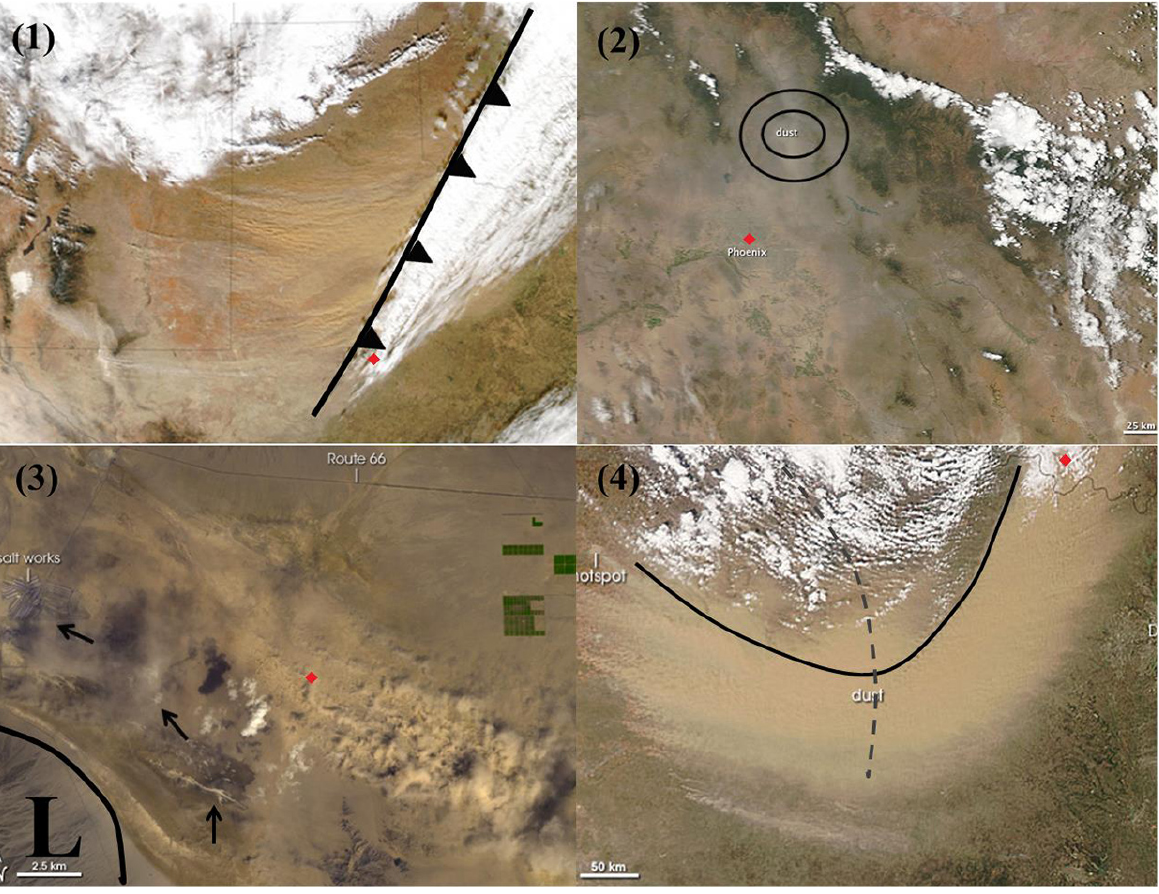
Figure 1. Four typical dust storms over the western United States: visible satellite images and corresponding weather systems for the storms. (1) Dust storm caused by cold front (D1), 15 December 2003, at Texas and Oklahoma border. (2) Dust storm caused by meso- or small- scale system (D2), 5 July 2011, near Phoenix, Arizona. (3) Dust storms caused by disturbances (D3), 12 April 2007, near Amboy, southern California. (4) Dust storm caused by cyclogenesis and associated trough cutoff (D4), 24 February 2007, west of Dallas, Texas. Red marks show the location of available reference air quality sites used in our analyses. (Image credit: NASA earth